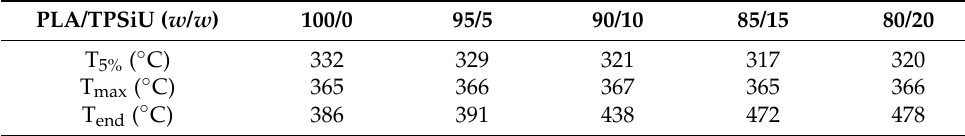
Figure 6. TGA curves of PLA/TPSiU blends ( a ) and corresponding DTG curves ( b ). Table 2. TGA parameters for PLA/TPSiU